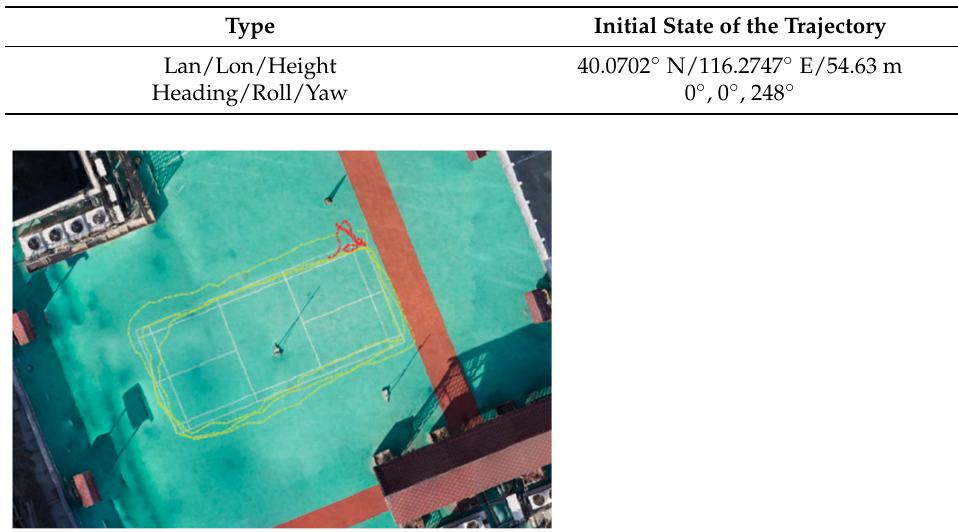
Table 2. Initial state parameters of the trajectory.